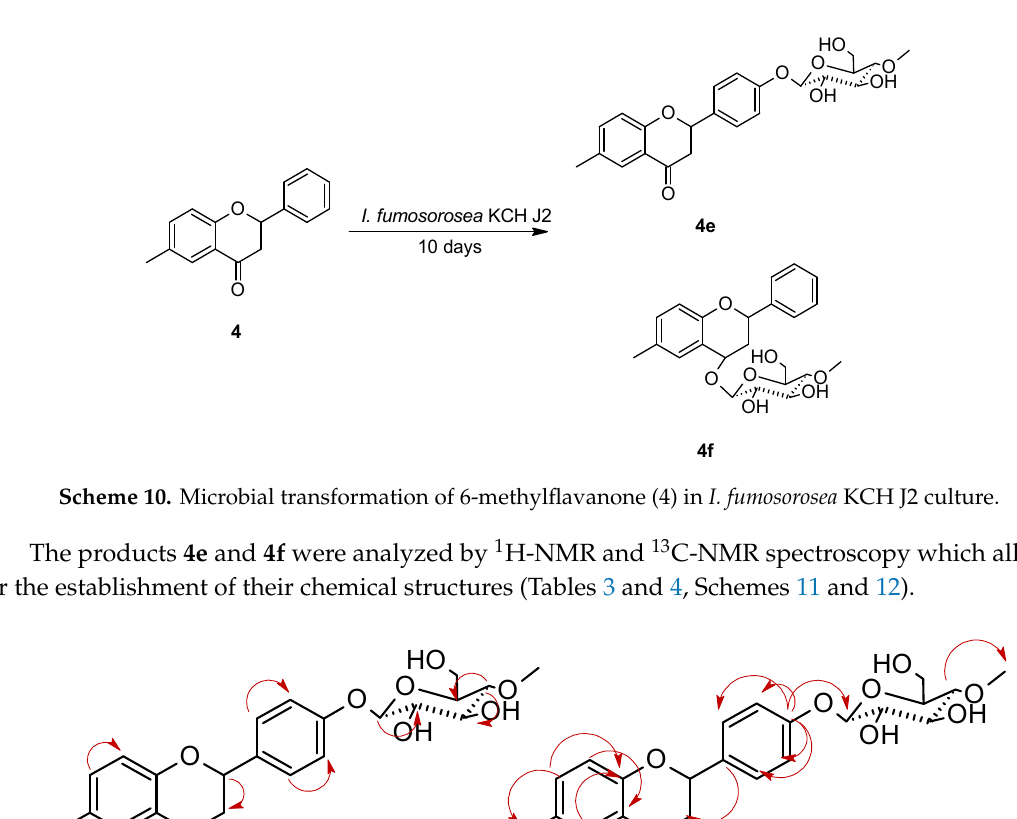
Scheme 11. Key COSY (on the left) and HMBC (on the right) correlations for the structure elucidation of product 4e .